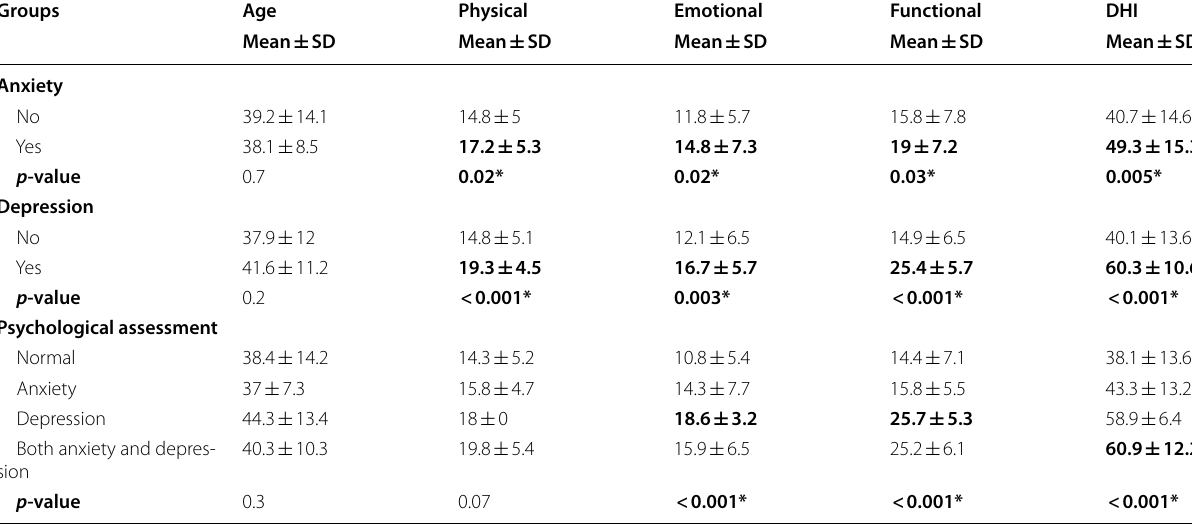
* P -value< 0.05 was considered as statistical significant